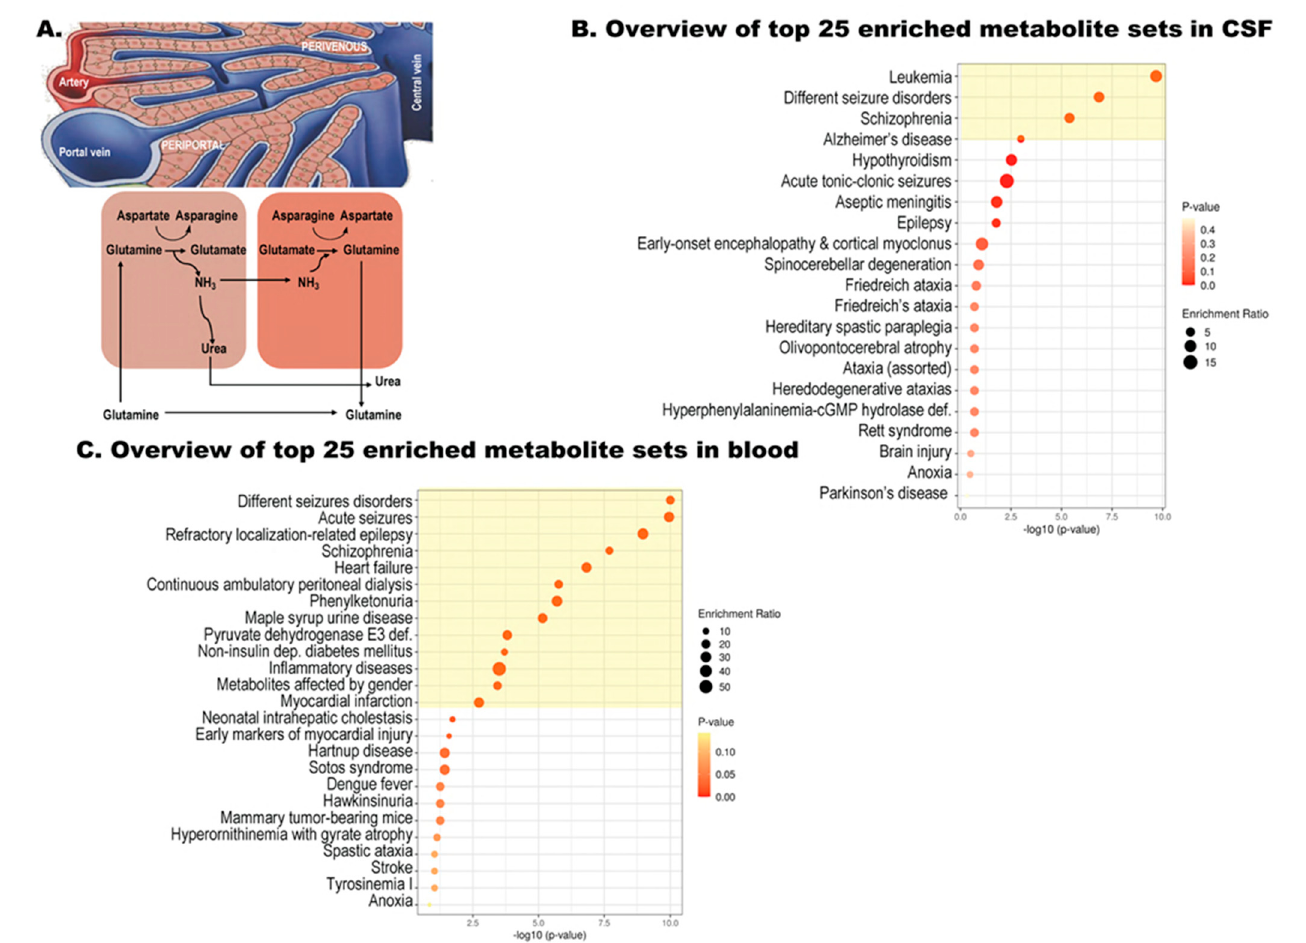
Figure 2. Enrichment analysis of outcomes identified by ANN and the intercellular glutamine cycle in WD. ( A ) Diagram showing the intercellular glutamine cycle as it occurs between the periportal cells and the perivenous ones surrounding the central vein. Copper accumulation induces liver toxicity, which results in lower urea cycle function undermining a safe disposal of the excess of ammonia as urea. Excess of ammonia, formed by the action of glutaminase on glutamine (among others), is then used to generate glutamate at the expense of the Krebs’ cycle intermediate alpha-ketoglutarate as well as increases in asparagine at the expense of aspartate. The lower activity of the Krebs’ cycle results in lower ATP production, which may challenge the ATP-driven generation of glutamine from glutamate. Enrichment analyses were performed by using the amino acids and derivatives identified under Figure 1B as input against a disease signature database in CSF ( B ) and blood ( C ). Those highlighted in yellow had an FDR < 0.05. The analysis was performed by using MetaboAnalyst [33].